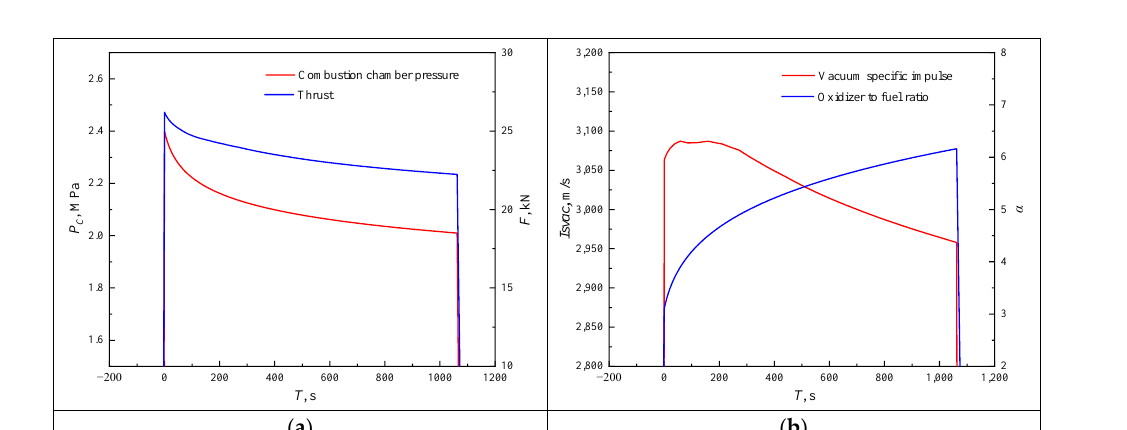
( b ) Figure 17. Parametric analysis of design variables to cost. ( a ) Pareto diagram; ( b ) main effect plot. ( a ) ( b ) Figure 18. Parametric analysis of design variables to velocity increment. ( a ) Pareto diagram; ( b ) main effect plot.